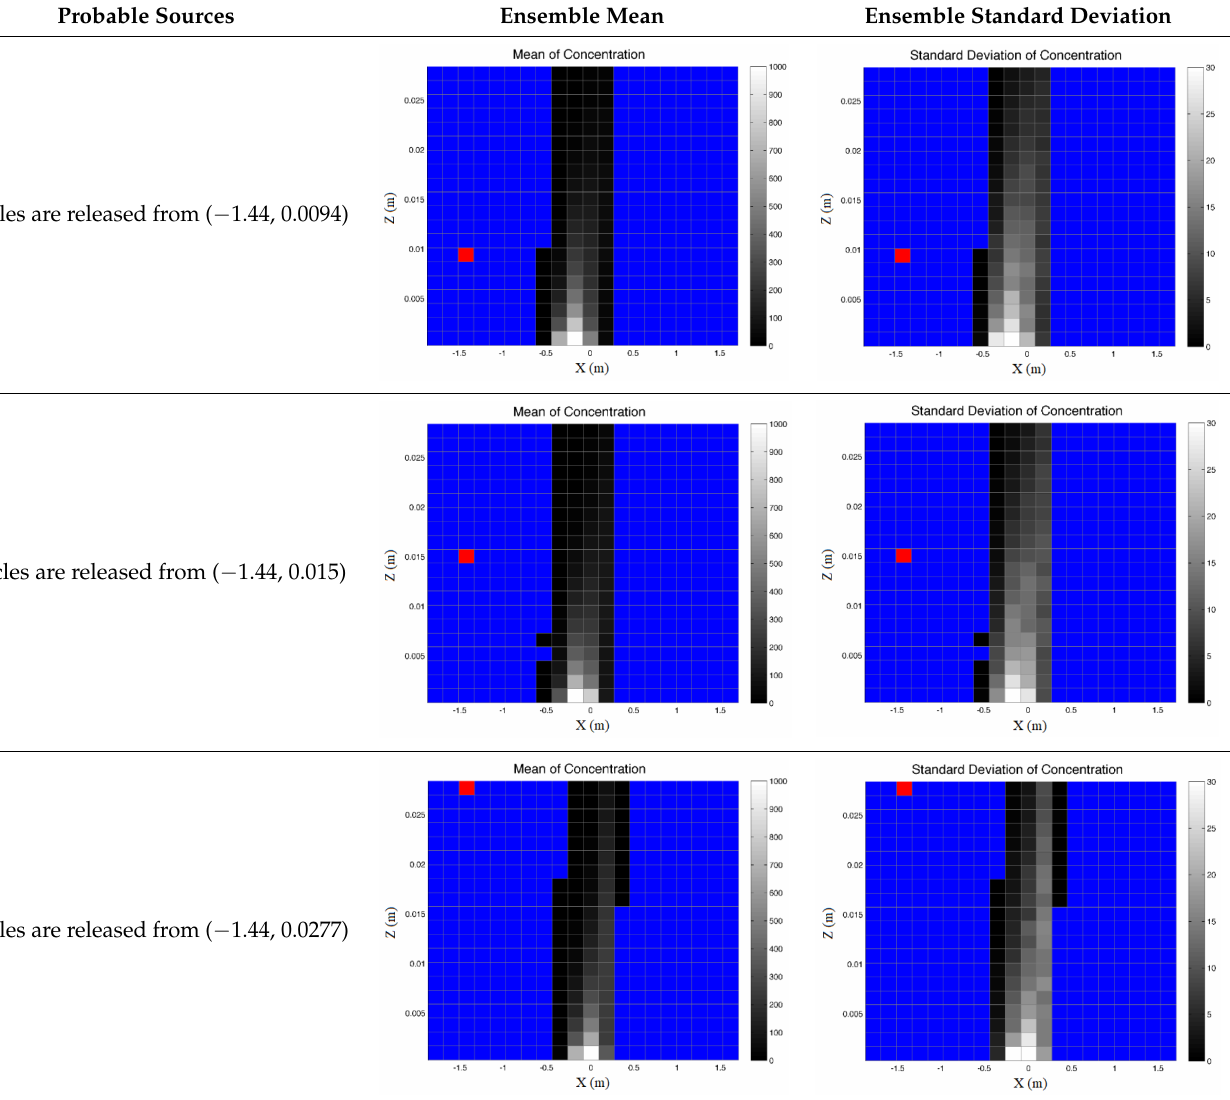
Table 4. The ensemble mean and ensemble standard deviation of spatial sediment concentration distribution from 8 different probable